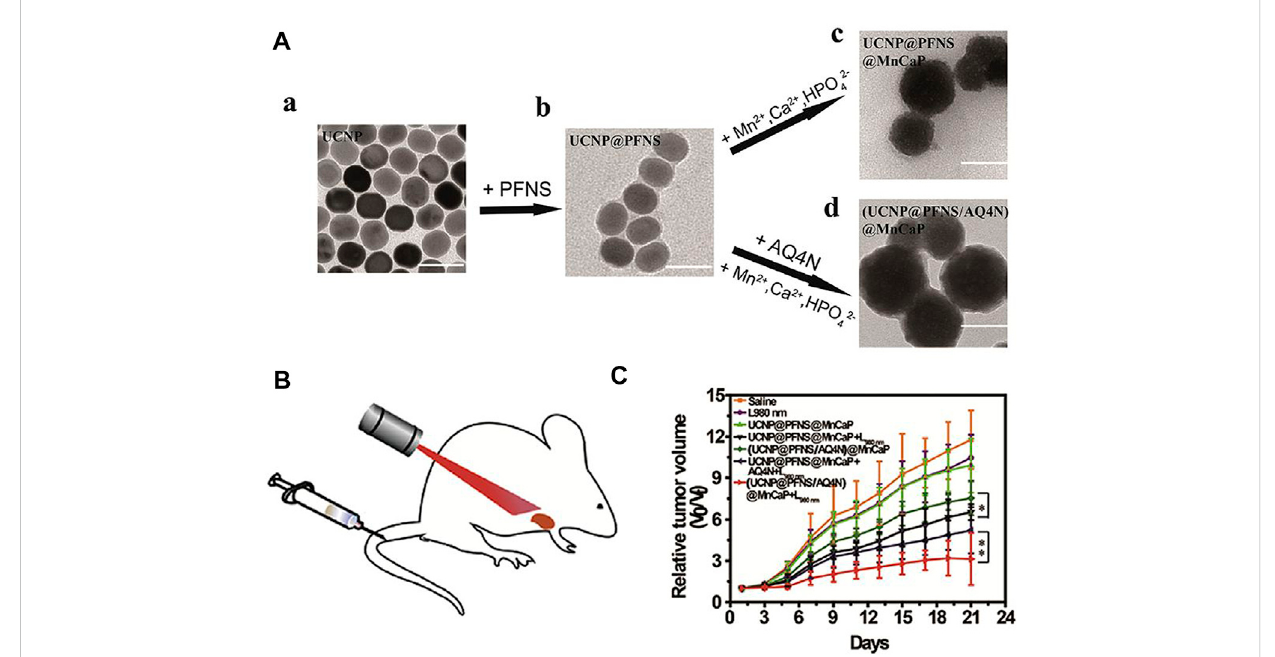
FIGURE 6 (A) Transmission electron microscope (TEM) images of Ln-UCNPs (a), Ln-UCNPs@PFNS (b), Ln-UCNPs@PFNS@MnCaP (c) and (Ln-UCNPs@PFNS/ AQ4N) @MnCaP (d). (B) Schematic of the treatment of mice with intravenously injected (Ln-UCNPs@PFNS/AQ4N)@MnCaP and treatment by illumination. (C) The tumor growth curves for different treatments. Error bars indicate SD ( n = 6). [Reprinted with permission from Ref. (Ji et al.,